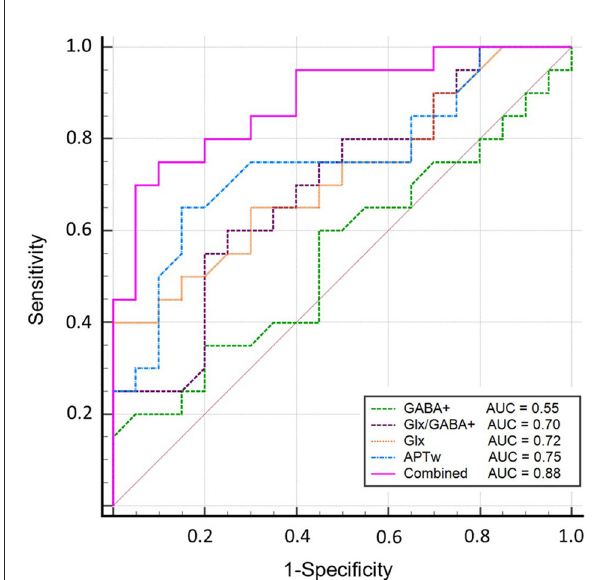
FIGURE6 Diagnostic performance of Glx, GABA + , Glx/GABA + ratios, and APTw and the combined parameters. The ROC curve analysis showed that GABA + has the lowest AUC of 0.55; Glx, Glx/GABA + ratios, and APTw values have similar areas under the curve (AUC) of 0.72, 0.70, and 0.75, respectively, for the diagnosis of aMCI; a combination of these parameters demonstrated an increased AUC value of 0.88.